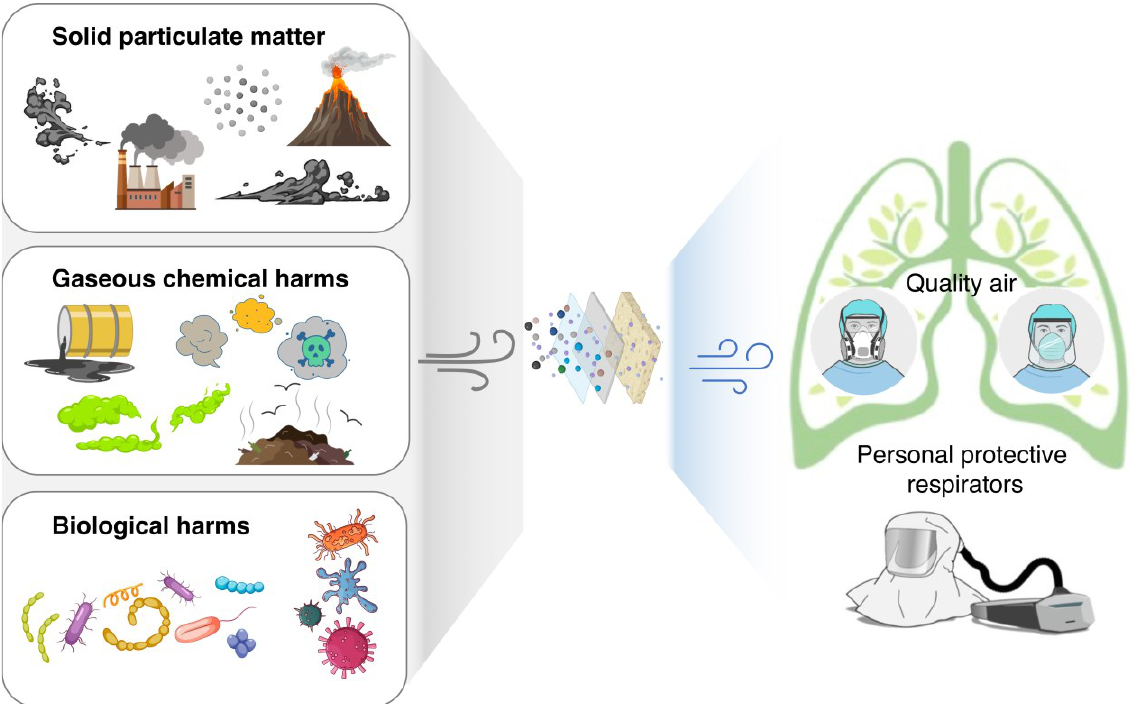
Figure 1. Mask filters out pathogens from the environment and provides wearers with quality air.